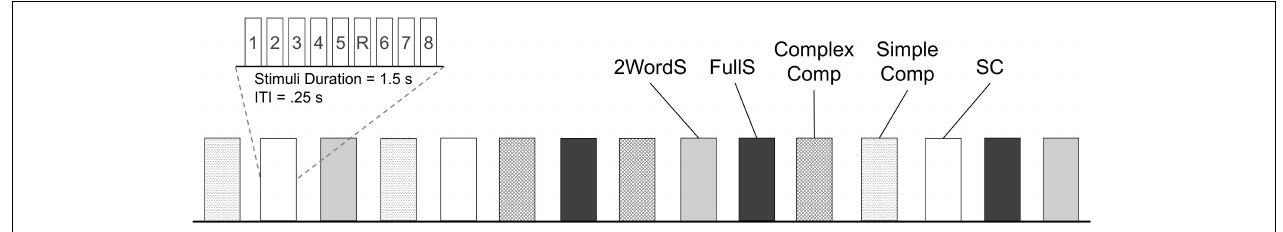
FIGURE 1 | Schematic representation of the experimental design. Functional activations associated with the processing of stimuli from 5 experimental conditions (SC, Small Clauses; FullS, Full Sentences; 2WordS, Two-word Sentences; Simple Comp, Simple Compounds; Complex Comp, Complex Compounds) were tested using a block design. In each block 8 unique stimuli were presented and participants were instructed to read the text and indicate with a button press any stimuli repetition (in this example, stimuli number 5 denoted by R). Each block lasted 15.75 s and was followed by a 10 s inter-block interval. Three blocks were presented per each of the experimental conditions for a total of 24 stimuli per condition. The total run time was 6 min 26 s. ITI, interval between stimulus presentations within a block; Block and Stimuli within a block are represented by vertical